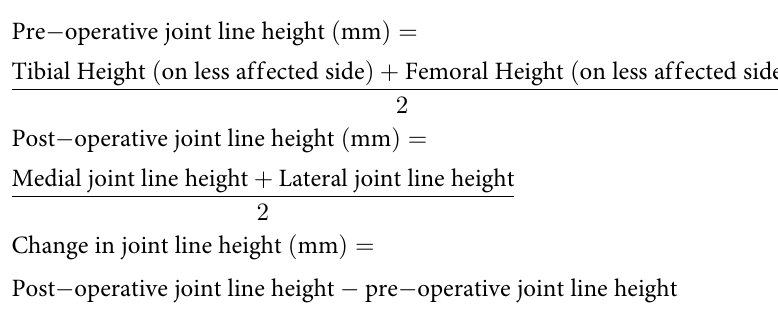
Fig 2. Post-operative IJLCM technique. Assessment of post-operative joint line height calculated as the average value of the Lateral Femoral Condyle (LFC) Height and the Medial Femoral Condyle (MFC) Height.